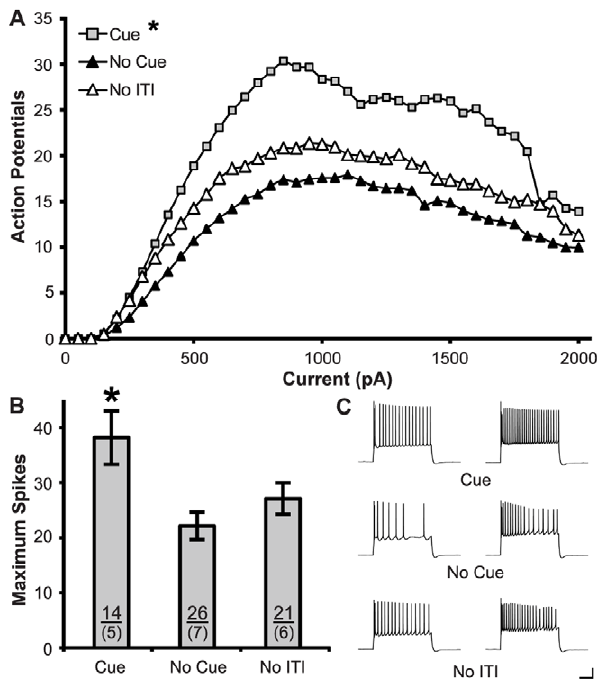
Figure 6. Training in the Cue condition increased the intrinsic excitability of infralimbic neurons. A. Action potentials were produced by increasing current steps (800 ms, 50 pA steps). Greater spiking occurred in the Cue condition than in the ITI only and No ITI conditions. B. Learning the cue increased the maximum number of action potentials evoked. Sample sizes for subjects (above) and cells (below) are indicated within the bars. C. Representative traces show action potentials generated by 500 pA (left) and 1000 pA (right) current steps for differing behavioral conditions. (Calibration Bars: 20 mV/0.1 s; * : p , 0.05 vs. all groups).